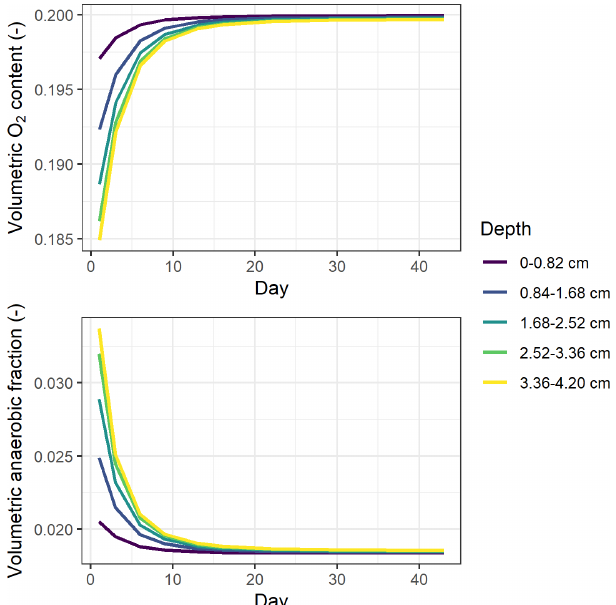
Figure 8. Simulated O 2 content and volumetric anaerobic fraction by the multi-layer model for the treatment with the greatest soil res- piration rate (i.e., RC treatment with NO − addition at 60% WFPS). 3 The mean daily values from posterior runs were used